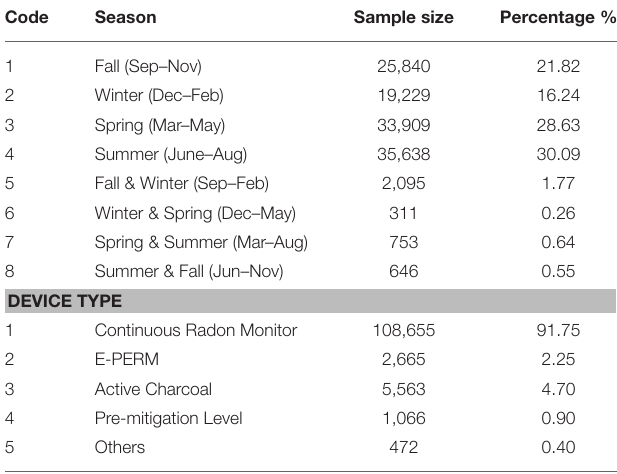
TABLE 1 | Device types and seasons for the radon concentrations from 2007 to